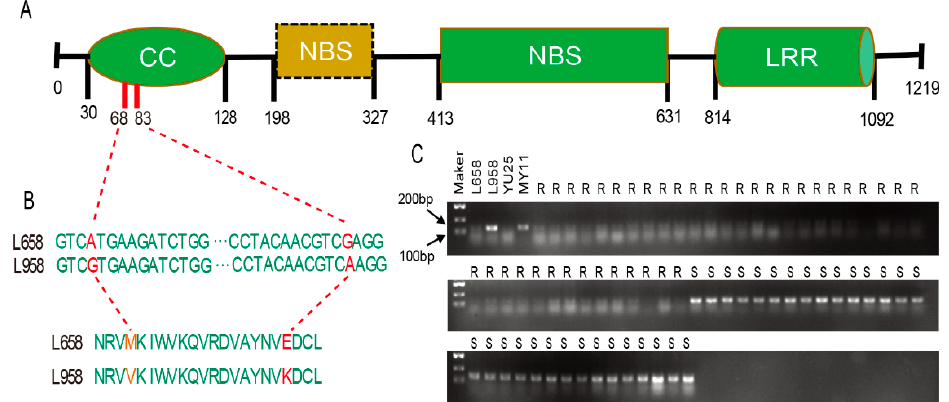
Figure 4. Sequence analysis of TraesCS7B01G164000 and SNP identification in the L658 sister line. ( A ) The TraesCS7B01G164000 domain composition and mutation sites (mutations in red indicate changes in amino acids, and vertical lines indicate positions of corresponding domains). ( B ) Two SNPs located in the coding region of TraesCS7B01G164000 were found in the Pm40 -carrying wheat line L658 and susceptible sister line L958. ( C ) SNP validation of TraesCS7B01G164000 in 39 resistant lines and 30 susceptible sister lines of L658 by AS-PCR .